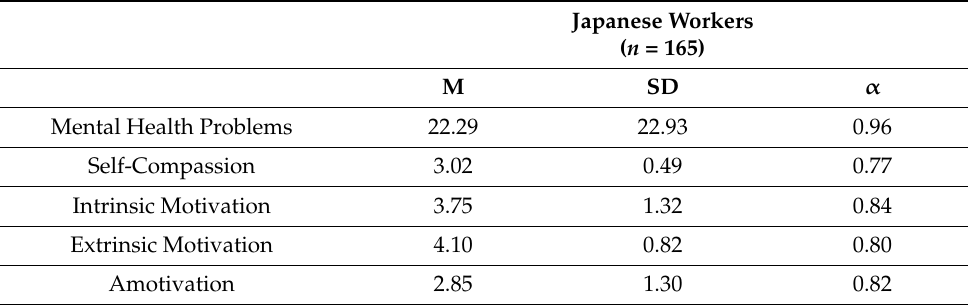
Table 1. Descriptive statistics.